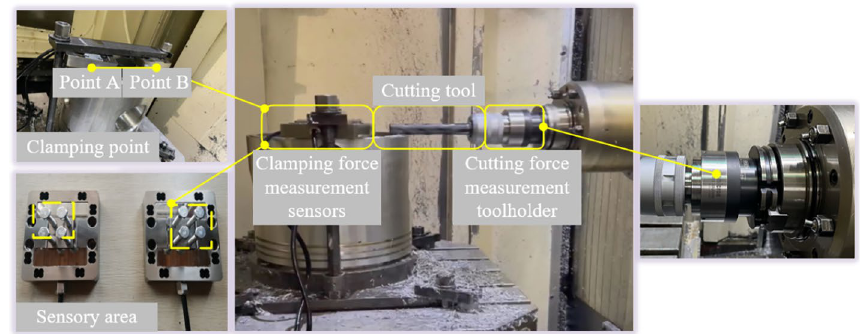
Figure 7. Machining